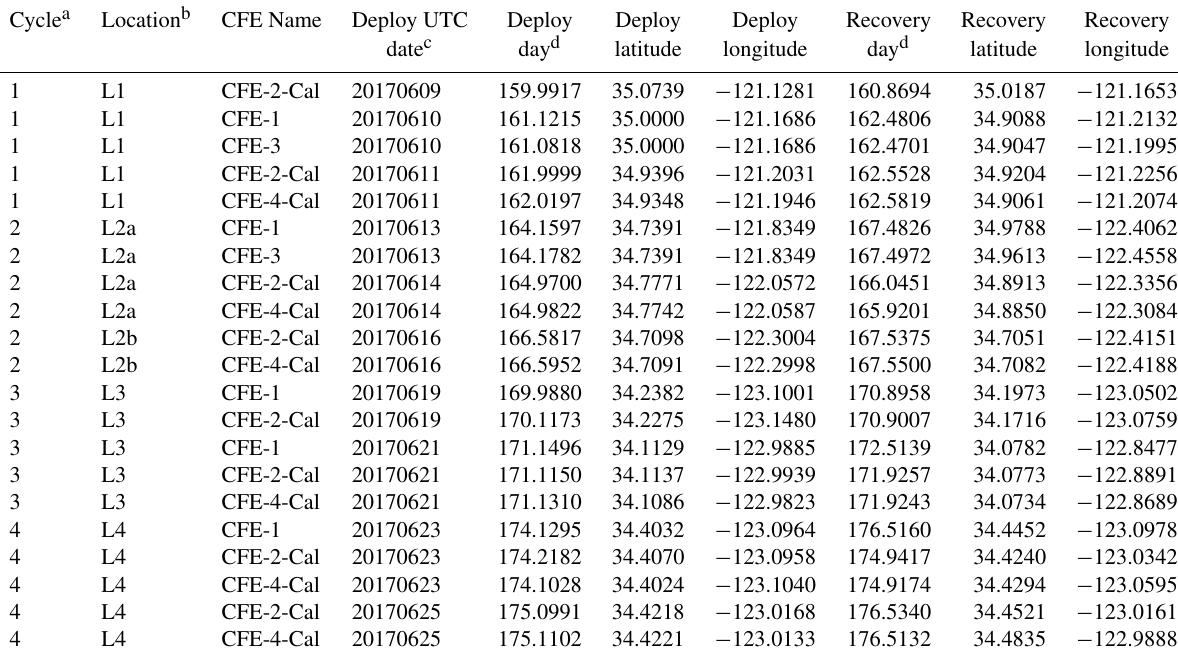
Table 1. Carbon flux explorer deployments during CCE-LTER process study P1706 2 June–1 July 2017. Cycle